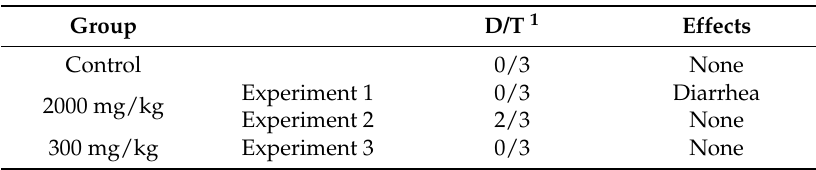
Table 1. Effects of single-dose (i.p.) administration of the N -(p-nitrophenyl)acetamide piperinoate (HE-02) in mice.